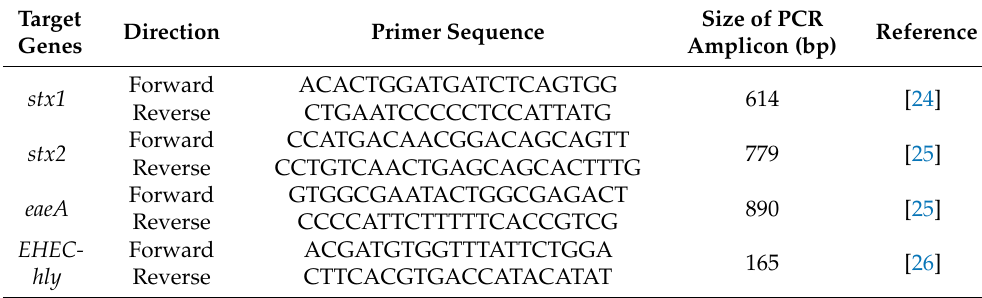
Table 1. List of primer sequences, target genes, and predicted lengths of amplification